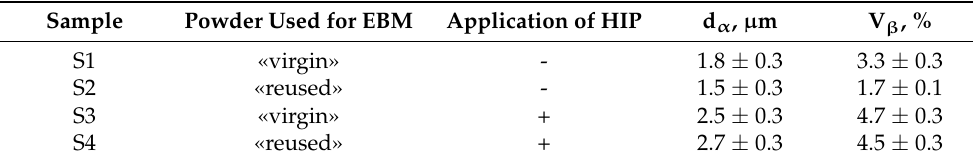
Table 3. Process parameters and microstructure characteristics of the samples. Sample Powder Used for EBM Application of HIP d α , µ